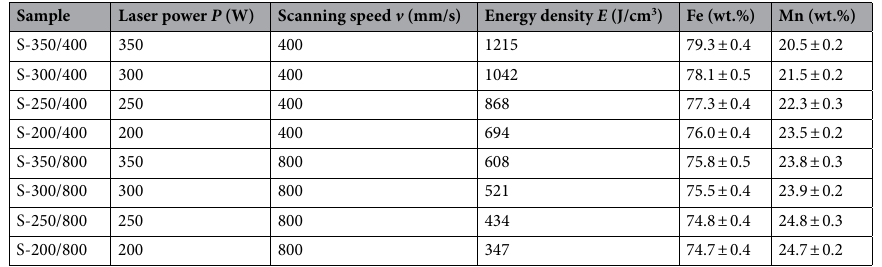
Table 1. Sample labelling with process parameters and final chemical compositions